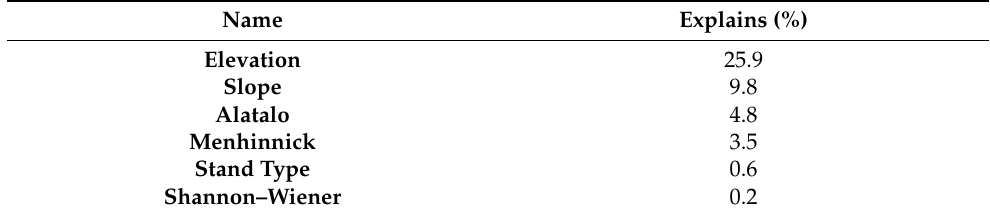
Table 5. Correlation analysis of soil